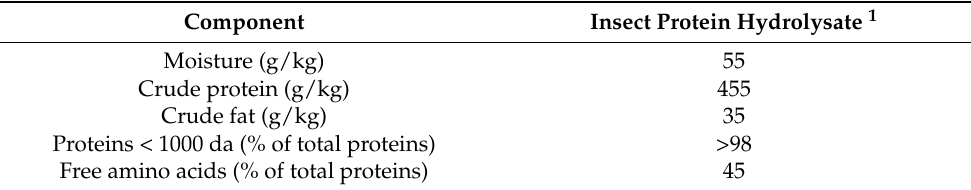
Table 4. Chemical composition of insect protein hydrolysate (as declared by